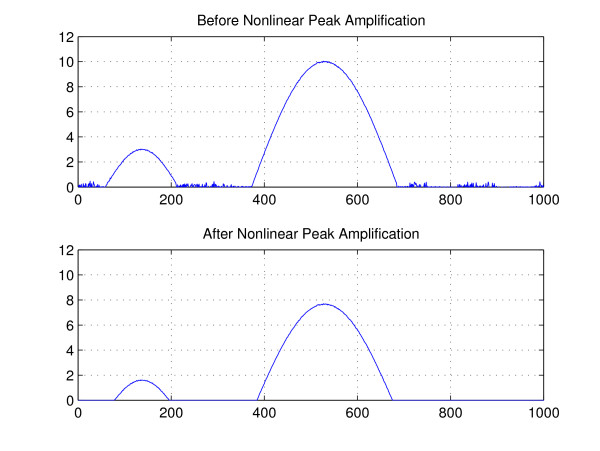
Illustration of simulated data before and after the nonlinear signal amplification. The noise with insignificant magnitude is removed by nonlinear signal amplification, thereby facilitating the subsequent peak collection step.